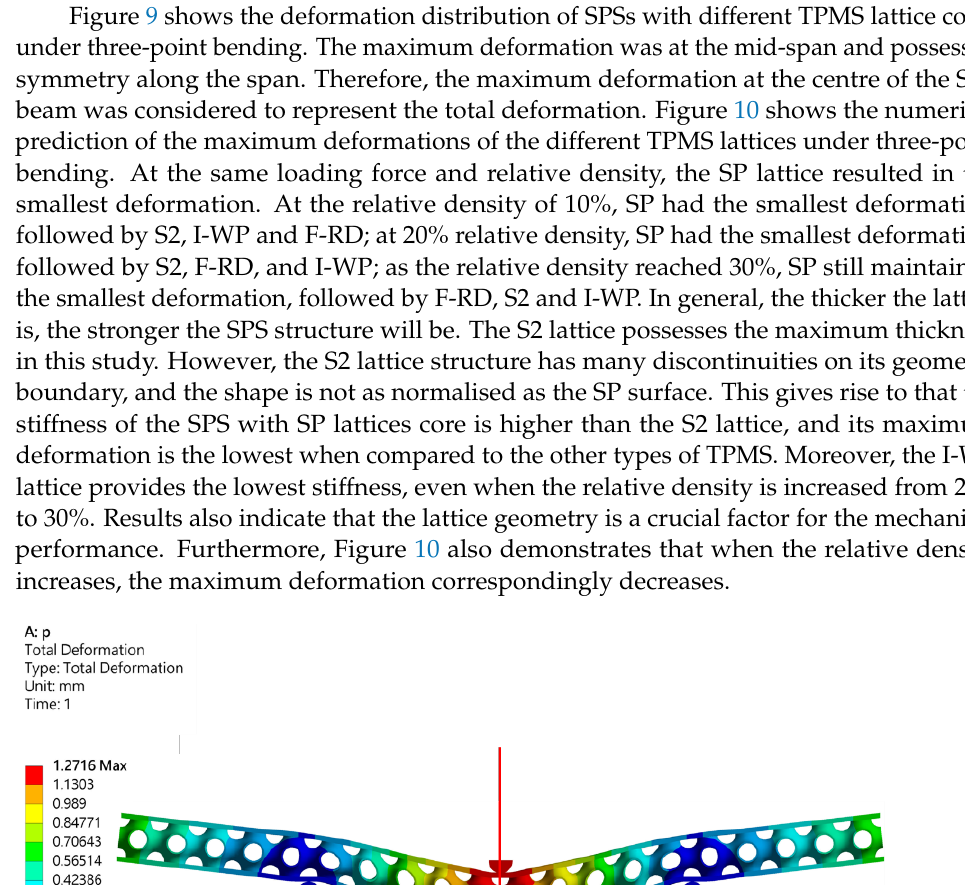
Figure 10. Maximum deformations of SPSs with different TPMS lattice cores. Because the numerical results were based on a three-point bending load, the defor- mation in the loading direction was also considered. Table 8 and Figure 11 compare the Z -axis deformations of the SPSs with different lattice cores. F-RD resulted in the smallest Z -axis deformation, which is because the lattice was being twisted when subjected to bending. The linear approximations of the total deformation error estimation, R 2 , of the SPSs with different TPMS lattice cores versus the relative density are presented in Table 9 and Figure 10. R 2 was close to 1 for all SPSs with the different lattice cores, which indicates that the linear approximated total deformation from Equations (12) to (15) can reliably predict the deformations of SPSs with different TPMS lattices. Table 8. Deformation along the Z -axis. Lattice